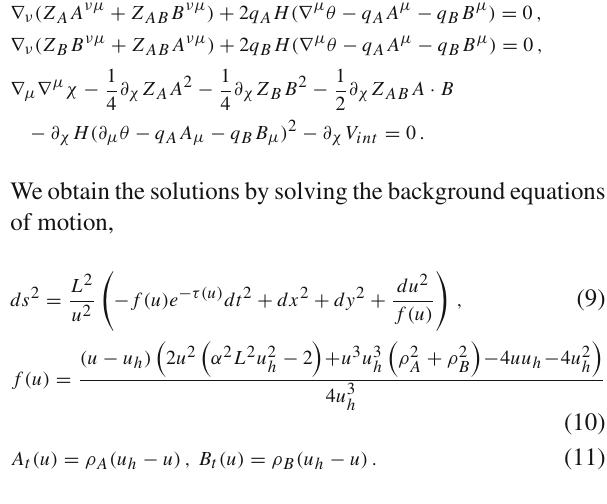
Fig. 3 Role of c : a The dome-shaped superconducting phase with the the coefficient c appearing in the expansion (6). b , c The left end- point x 1 and the right endpoint x 2 of the superconducting region. We